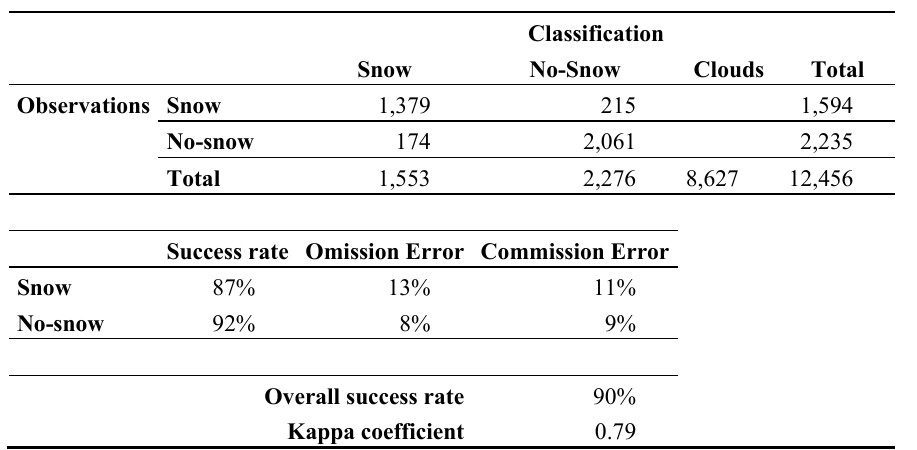
Table 3. Validation of the new version of the AVHRR algorithm using ground observations of snow from the 20 validation meteorological stations for the period